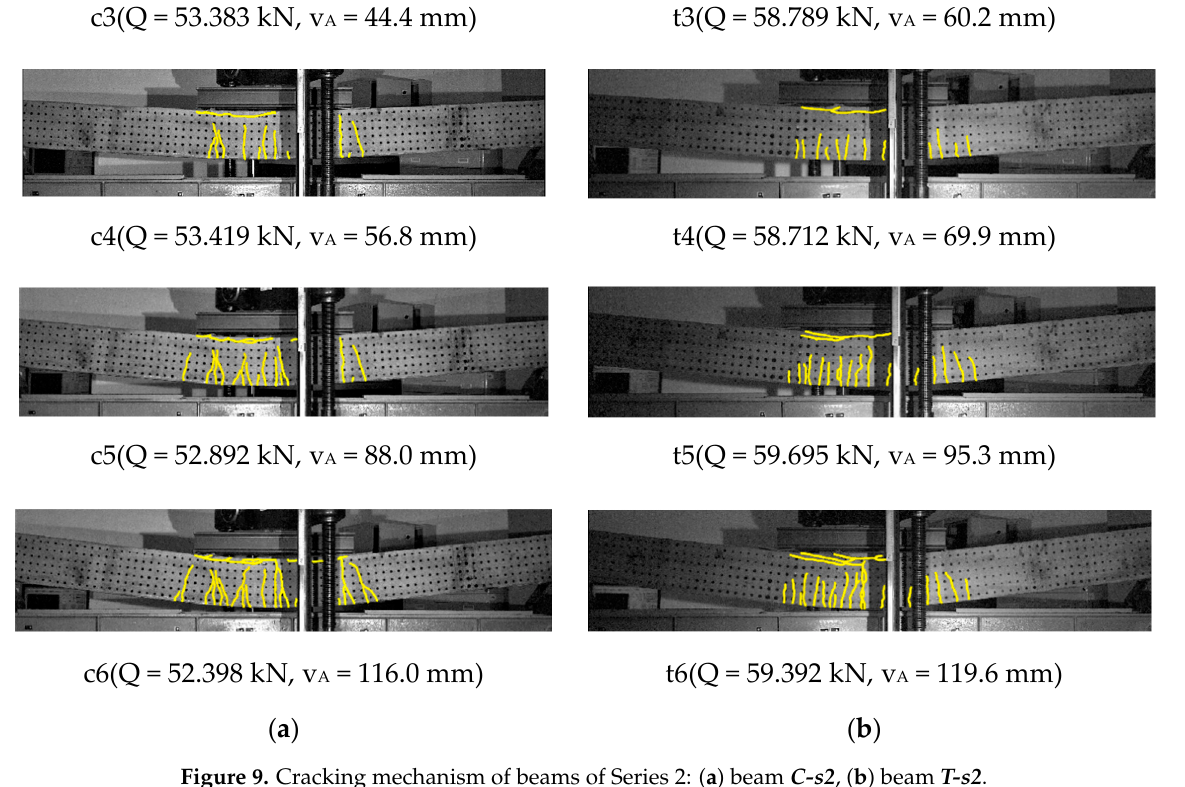
Figure 9. Cracking mechanism of beams of Series 2: ( a ) beam C-s2 , ( b ) beam T-s2 . In turn, Figure 10 shows enlarged images of the cracking state of beams of Series 2 for conventional reinforcement C-s2 for the point c6, Figure 10a, and for truss reinforcement T-s2 for the point t6, Figure 10b.